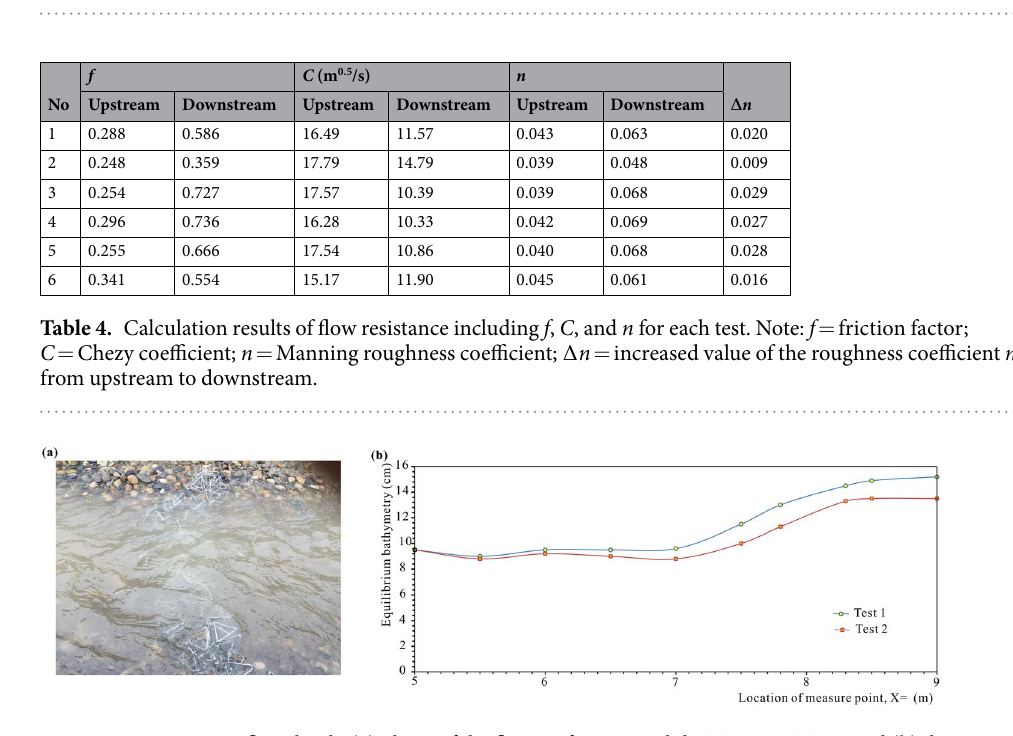
Figure 3. Variation in flow depth: ( a ) photo of the flow surface around the TFPW in Test 1 and ( b ) diagram of depth variation in Test 1 and Test 2, where X is the distance to the inlet of the flume. The TFPW is located at X = 8.0–8.1 m.